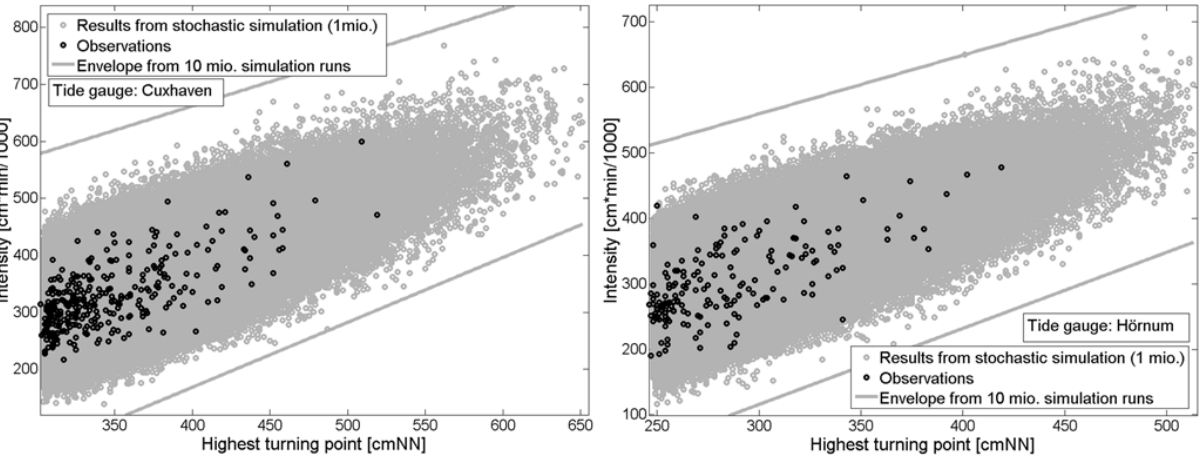
Fig. 1. Results from stochastic storm surge simulation performed by Wahl et al. (2011b) for the tide gauges of Cuxhaven (left) and H¨ornum